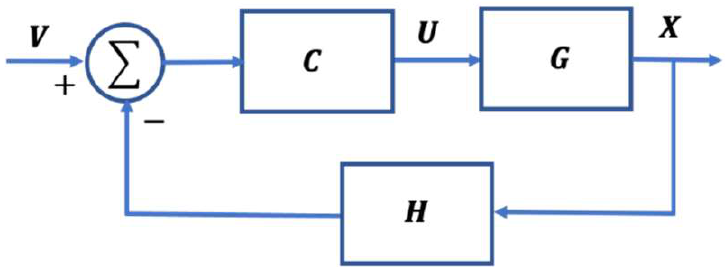
Figure 1. Control Architecture for Control Simulations using Techniques 1–4.